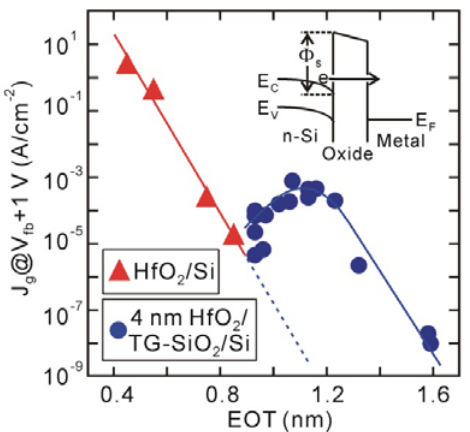
at V + 1 V for direct-contact HfO Figure 4. J g fb capacitors fabricated on n-type Si substrates. J increases with increasing Si oxide layer because of reduced conduction band offset ( Φ HfO /Si 2